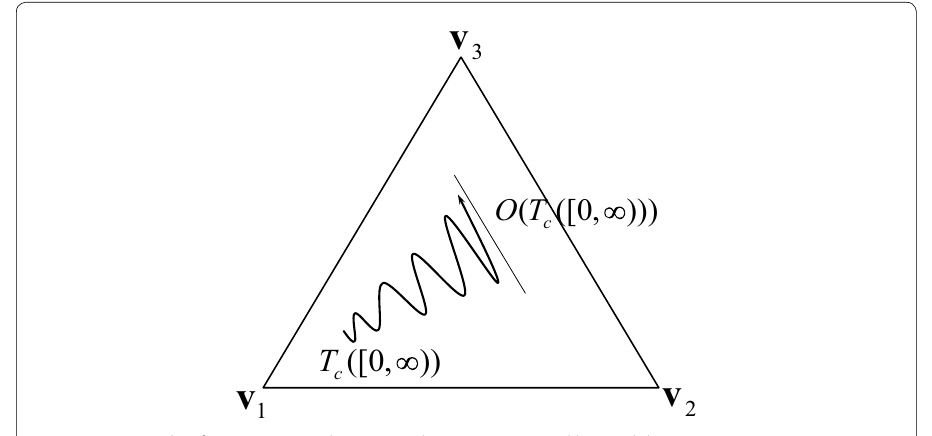
Fig. 9 An example of a trajectory and its omega limit set generated by Model